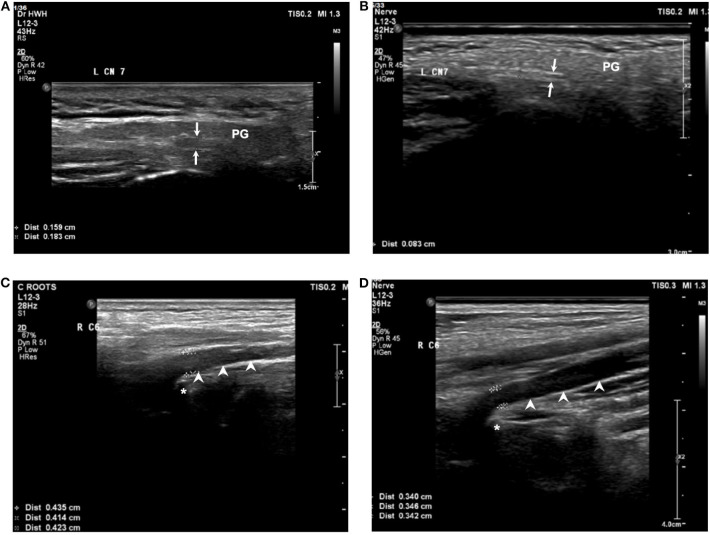
Sonography of facial nerve and cervical root at C6 level for the MFS and normal group at baseline. The width of the facial nerve (arrows) in a patient (A) with MFS was larger than in a control (B). The width of the cervical root (arrowheads) at C6 level in a patient with MFS (C) and a control (D). PG, parotid gland; asterisk: transverse process of the vertebrae.